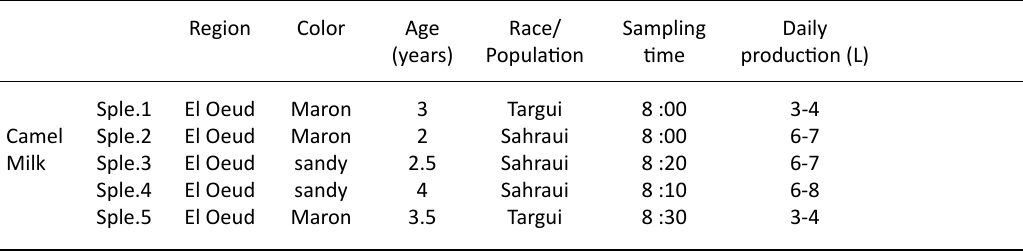
Table 1. Characteristics of breeds from which different milk was taken Region Color Age Race/ Sampling Daily (years) Population time production (L) Sple.1 El Oeud Maron Camel Sple.2 El Oeud Maron Milk Sple.3 El Oeud sandy Sple.4 El Oeud